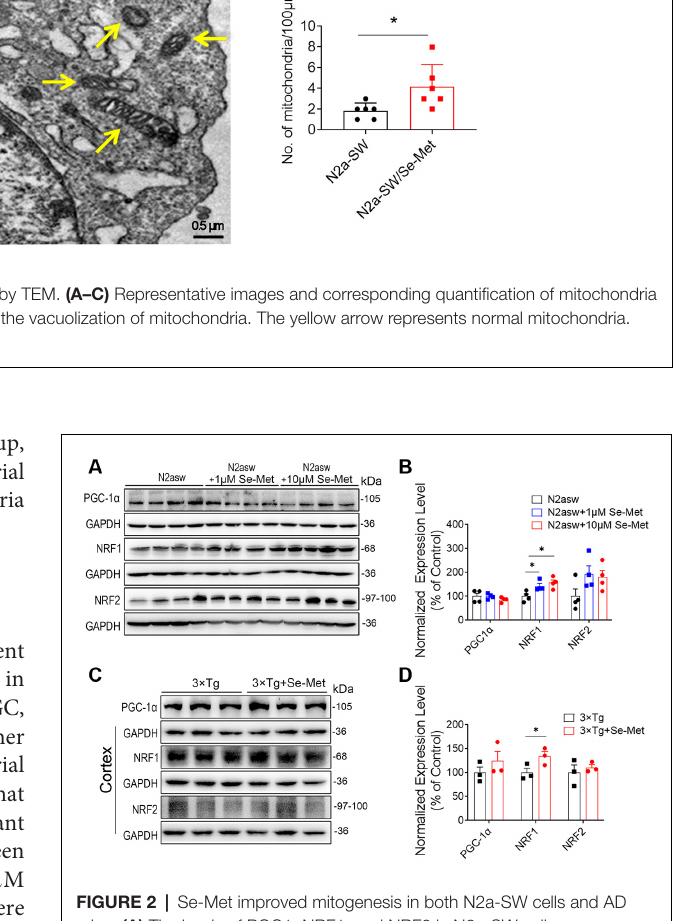
protein that mediates mitochondrial division, was also decreased significantly in AD mice ( ∗ p < 0.05, n = 4; Figure 4